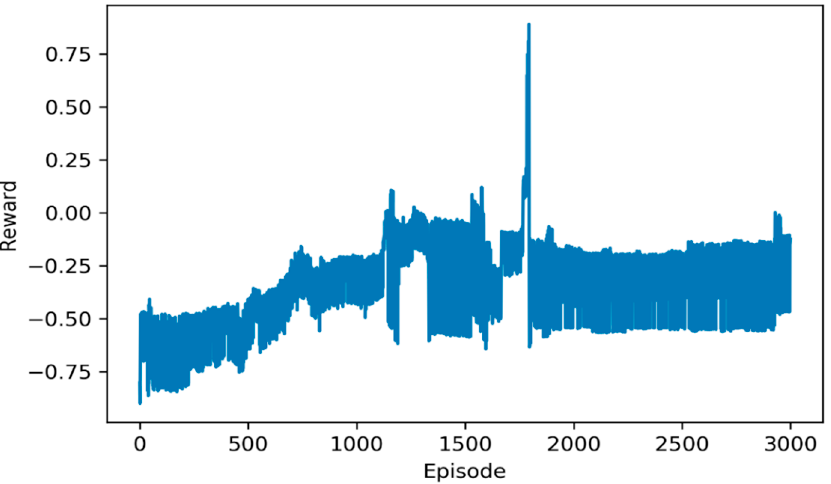
Figure 8. Rewards during training under discretely sampling random disturbances in the two-train network.